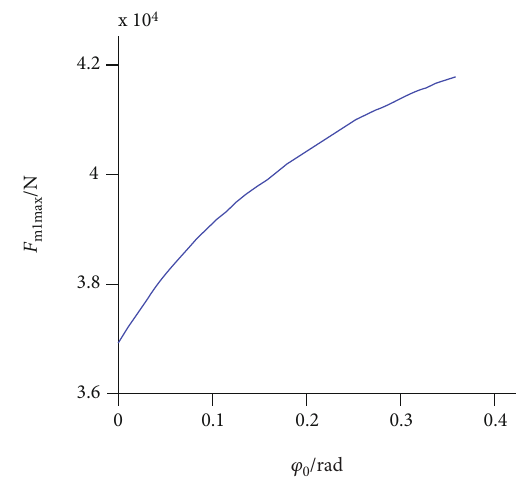
Figure 14: Max force on the primary strut 1 vs. initial pitch angle.